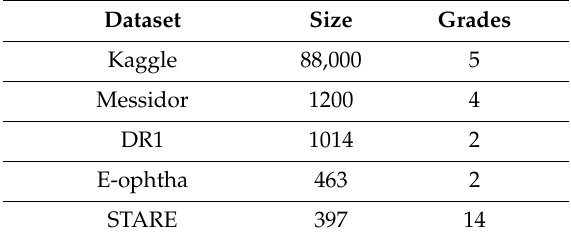
Table 2. Diabetic retinopathy (DR) datasets